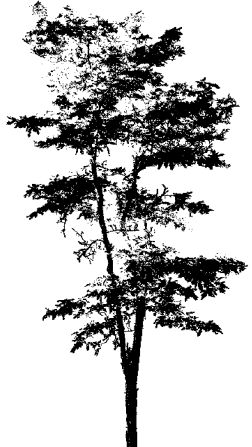
Figure 11. Point cloud of the actual broadleaf tree The results of the branch and stem points separation were shown in Figure 12. The LAD histogram of this broadleaf tree calculated with our TLS-based method was then shown in Figure